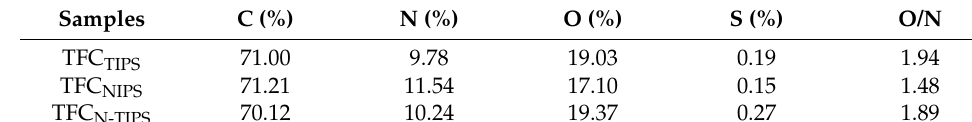
Figure 4. ( a ) ATR-FTIR spectra and ( b ) XPS spectra of TFC-FO membranes. Table 2. Surface element content of TFC-FO membranes measured by XPS.